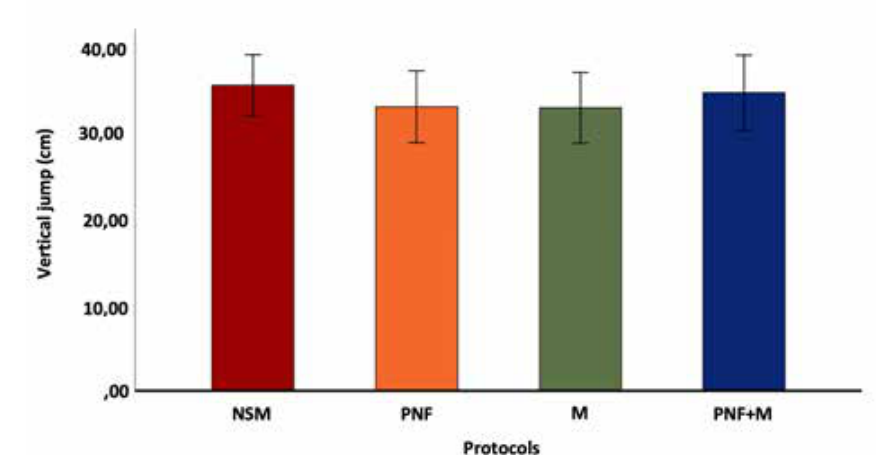
Figure 2. Vertical jump performance of four warm up and stretching